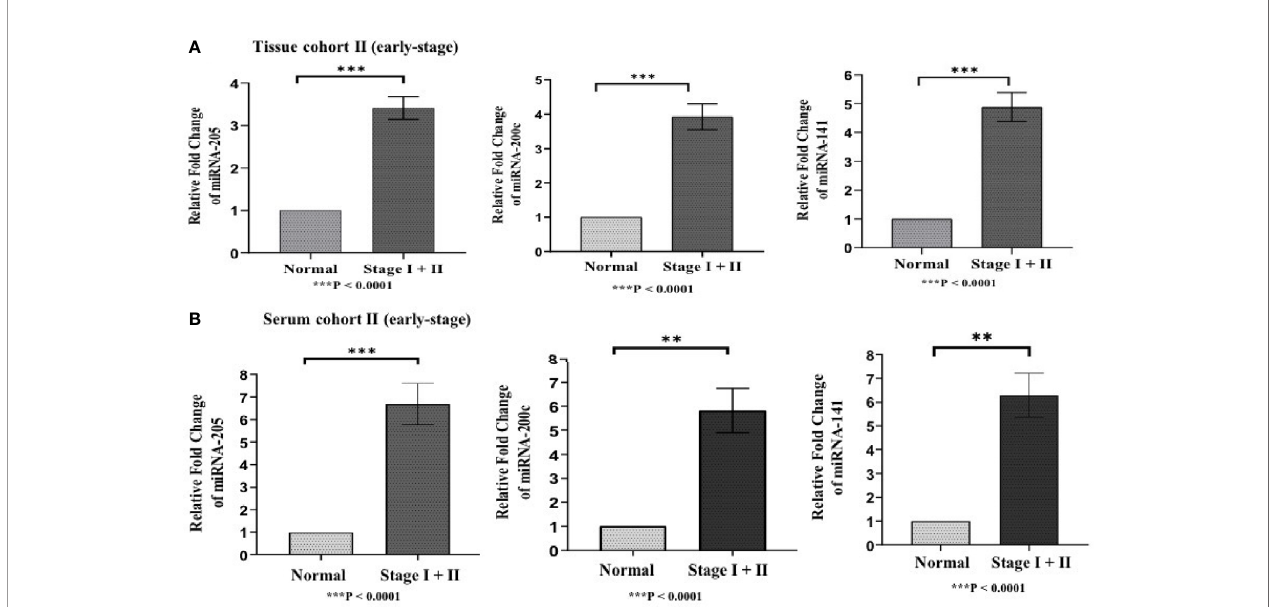
FIGURE 4 | Represents upregulation of miRNAs in epithelial ovarian cancer in cohort II of tissue and serum both. (A) In tissue cohort-II {n=71 (EOC=41, Normal=30)}, expression levels of miR-205, -200c, and miR-141 were signi fi cantly increased in the cancer group compared with the control group by 3.63 (P < 0.0001), 3.93 (P<0.0001) , 4.94 (P<0.0001) fold respectively. (B) In serum cohort-II {n=35 (EOC=21, Normal=14)}, the fold change of miR-205, miR-200c and miR-141 was 6.70 (P<0.0001), 5.82 (P = 0.0063), and 6.29 (p < 0.001) respectively. Statistically signi fi cant differences were determined by the Mann Whitney U-tests. Data represent mean ± standard error on the mean (SEM). **P < 0.01; ***P <